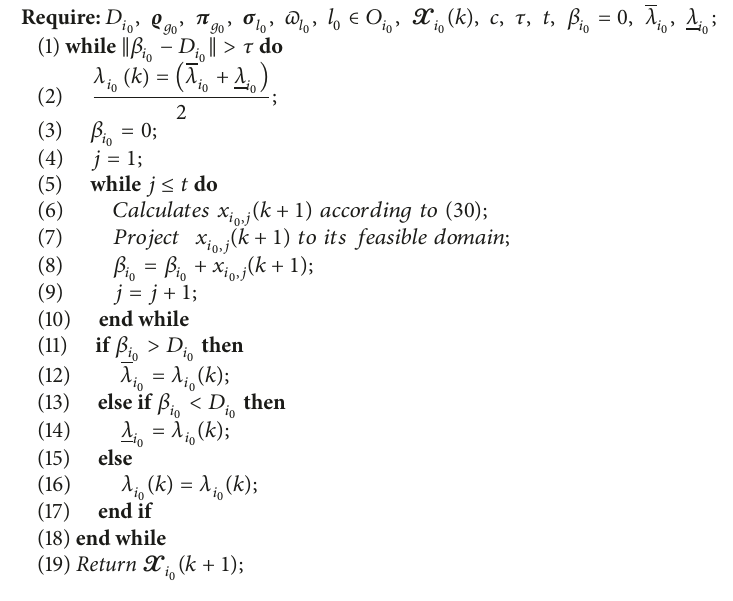
Algorithm 1: Day-ahead scheduling of